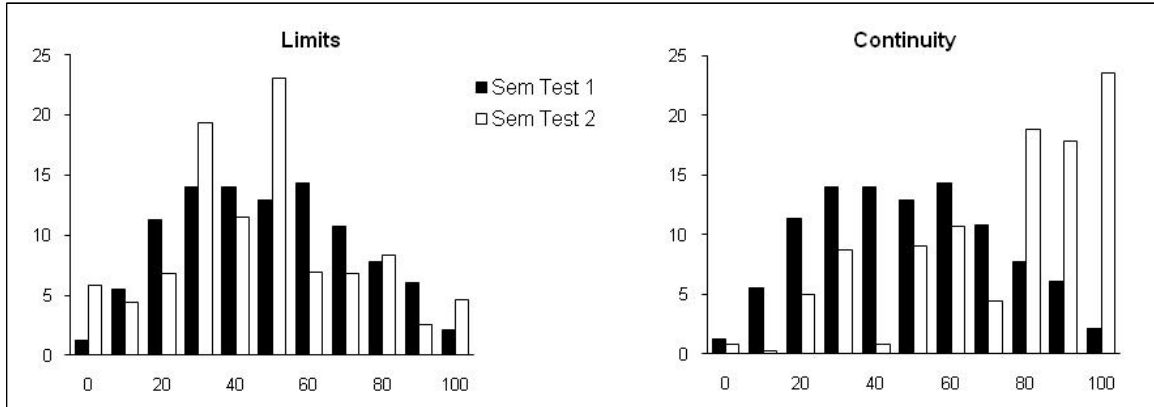
Figure 9 : Student performance in limits and continuity in Semester Tests 1 and